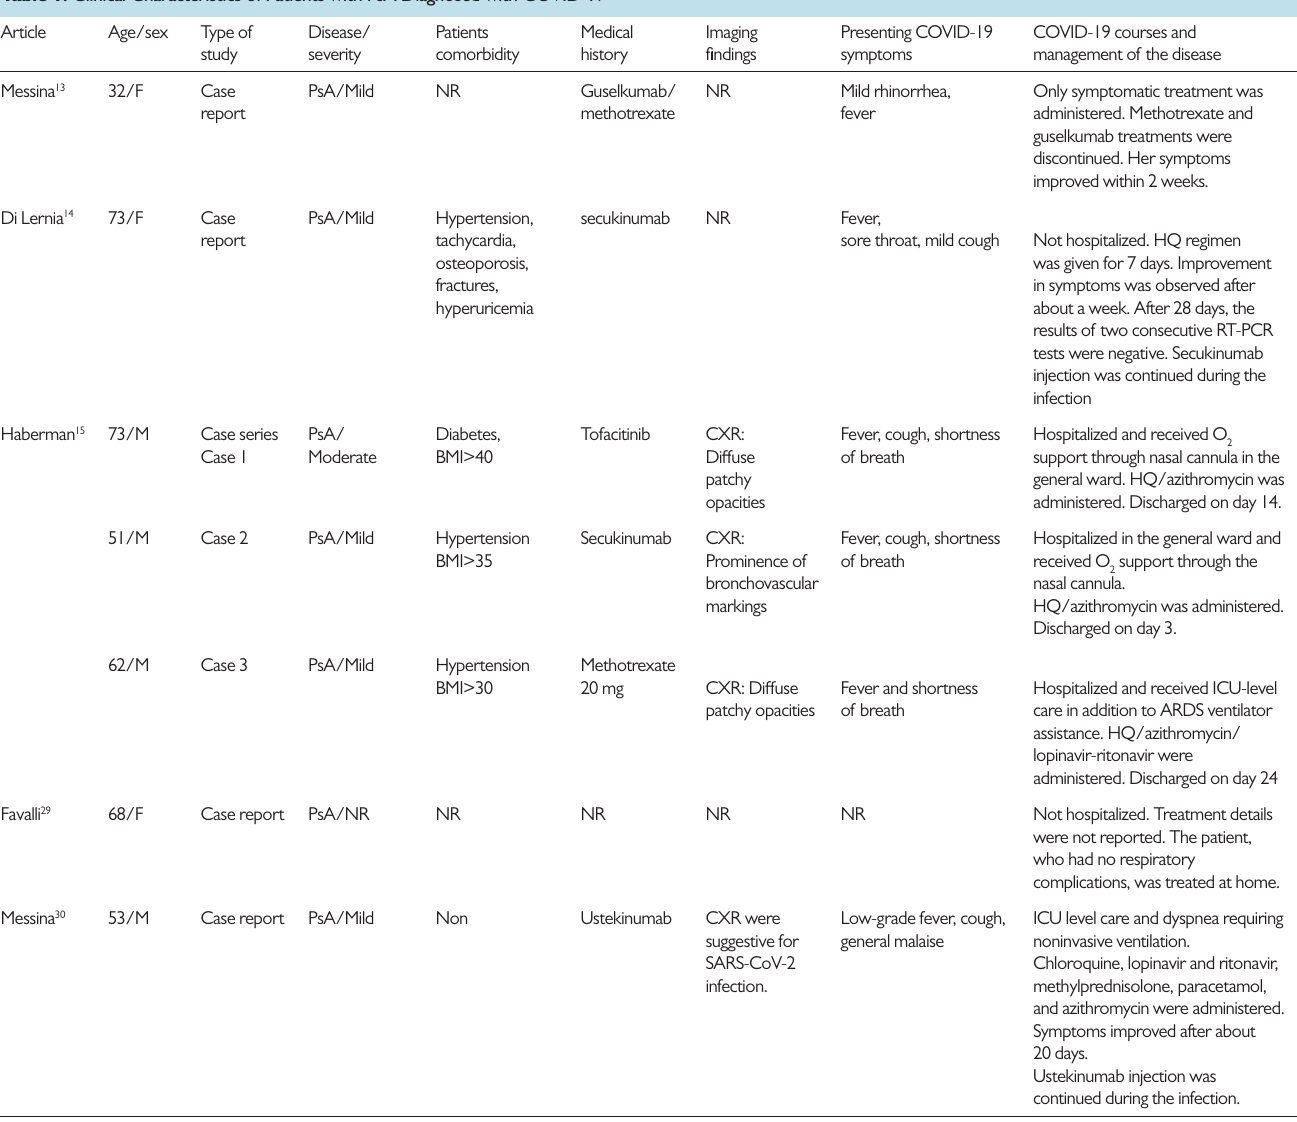
Table 1. Clinical Characteristics of Patients with PsA Diagnosed with